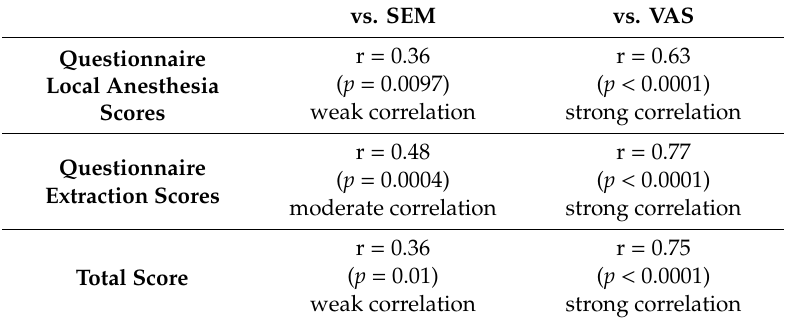
Table 3. Criterion validity analysis of questionnaire pain and discomfort scores vs. SEM and